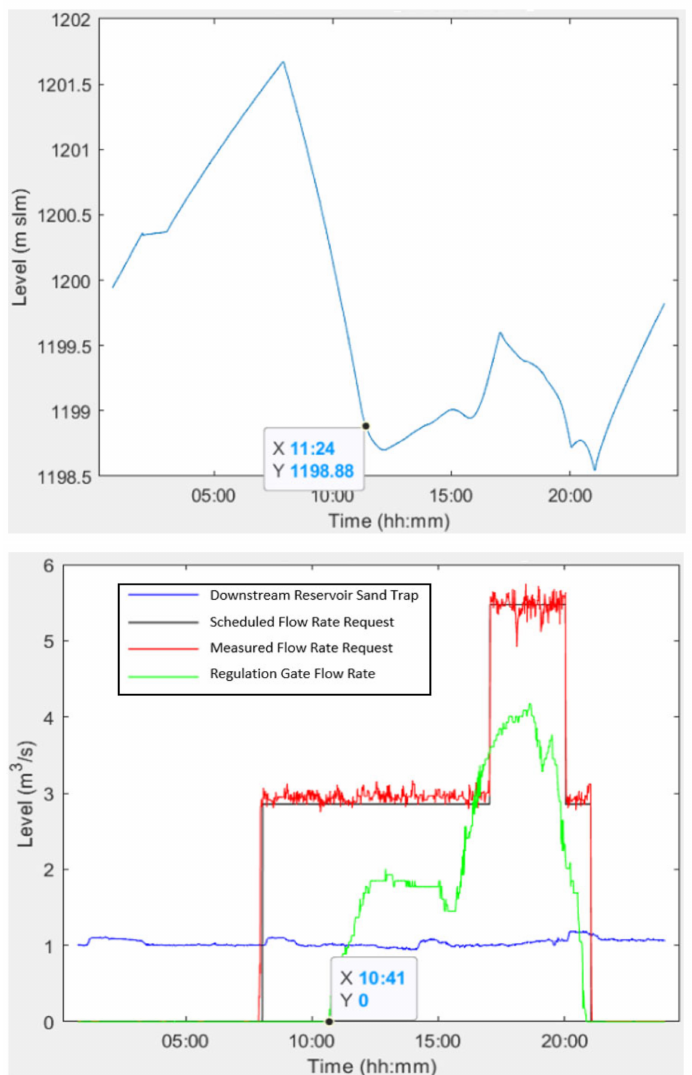
Figure 13. Modelization results: time delay between the Beikircher regulation gate’s flow rate and the downstream reservoir